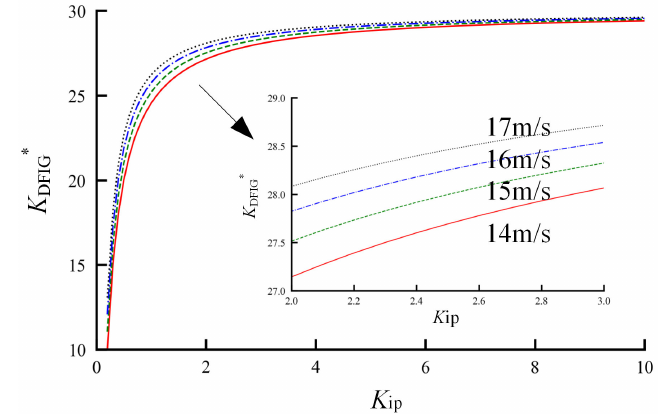
Figure 8. K DFIG with di ff erent K ip under di ff erent wind speeds.